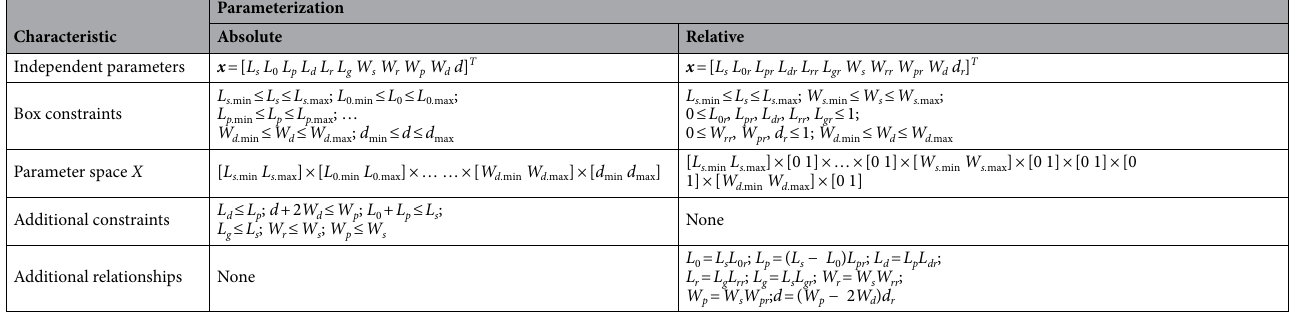
Table 1. Absolute versus relative parameterization for the monopole antenna of Fig. 1.